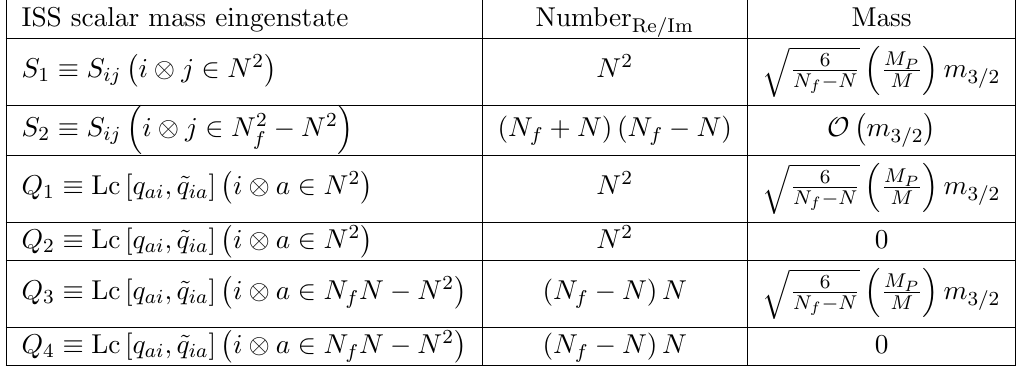
Table 1 . Tree-level largest contributions to the masses of the ISS scalar mass eigenstates. The notation is such that N 2 is the cartesian product N (cid:10) N with N = f 1 ; : : : ; N g , N 2 product N f (cid:10) N f , with N f = f 1 ; : : : ; N f g , and N f N is the cartesian product N f (cid:10) N with N = f 1 ; : : : ; N g and N f = f 1 ; : : : ; N f g . Furthermore, Lc stands for the linear combinations given from equations (2.32) to (2.35), and the second column gives the number of real or imaginary components for each type of ISS scalar mass